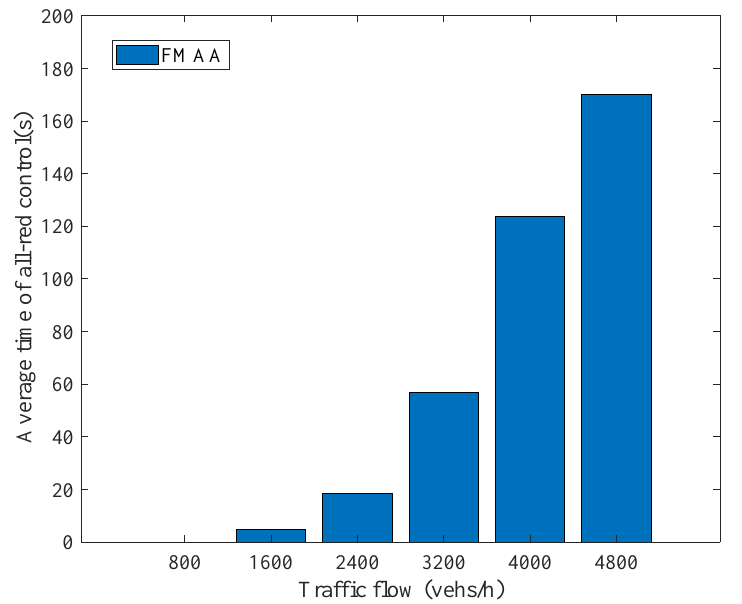
Figure 8. Average time of all-red